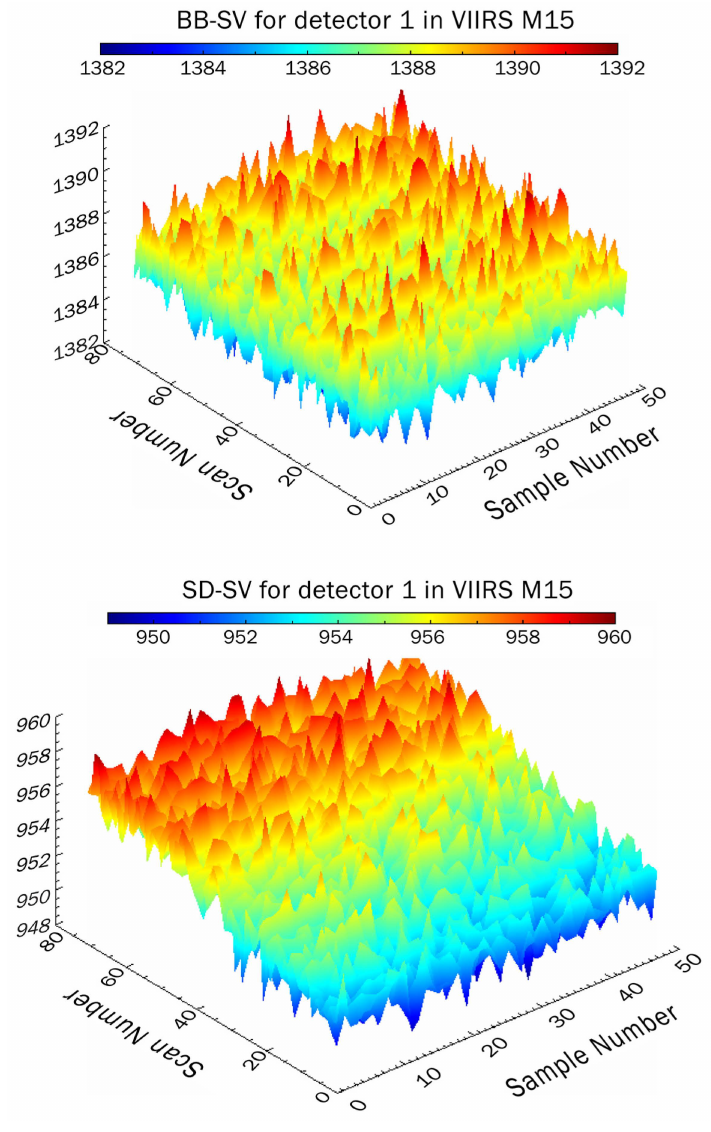
Figure 9. Variations of BB ´ SV ( i.e. , dBB; top ) and SD ´ SV ( i.e. , dSD; bottom ) along track and along scan for detector 1 in